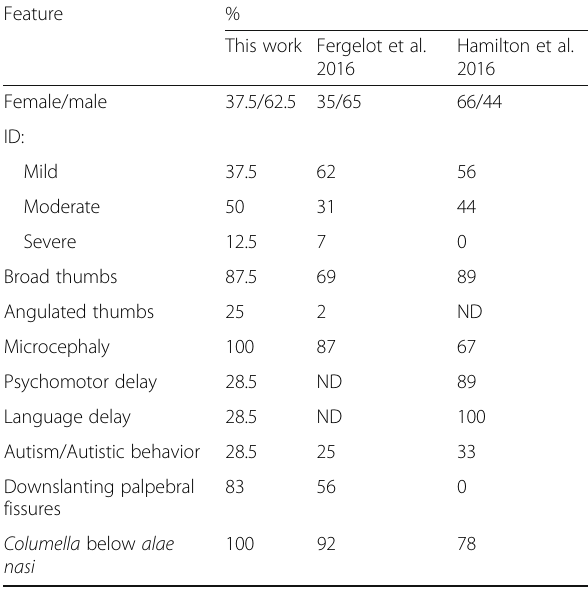
Table 2 Comparison of typical features in EP300 -patients found in